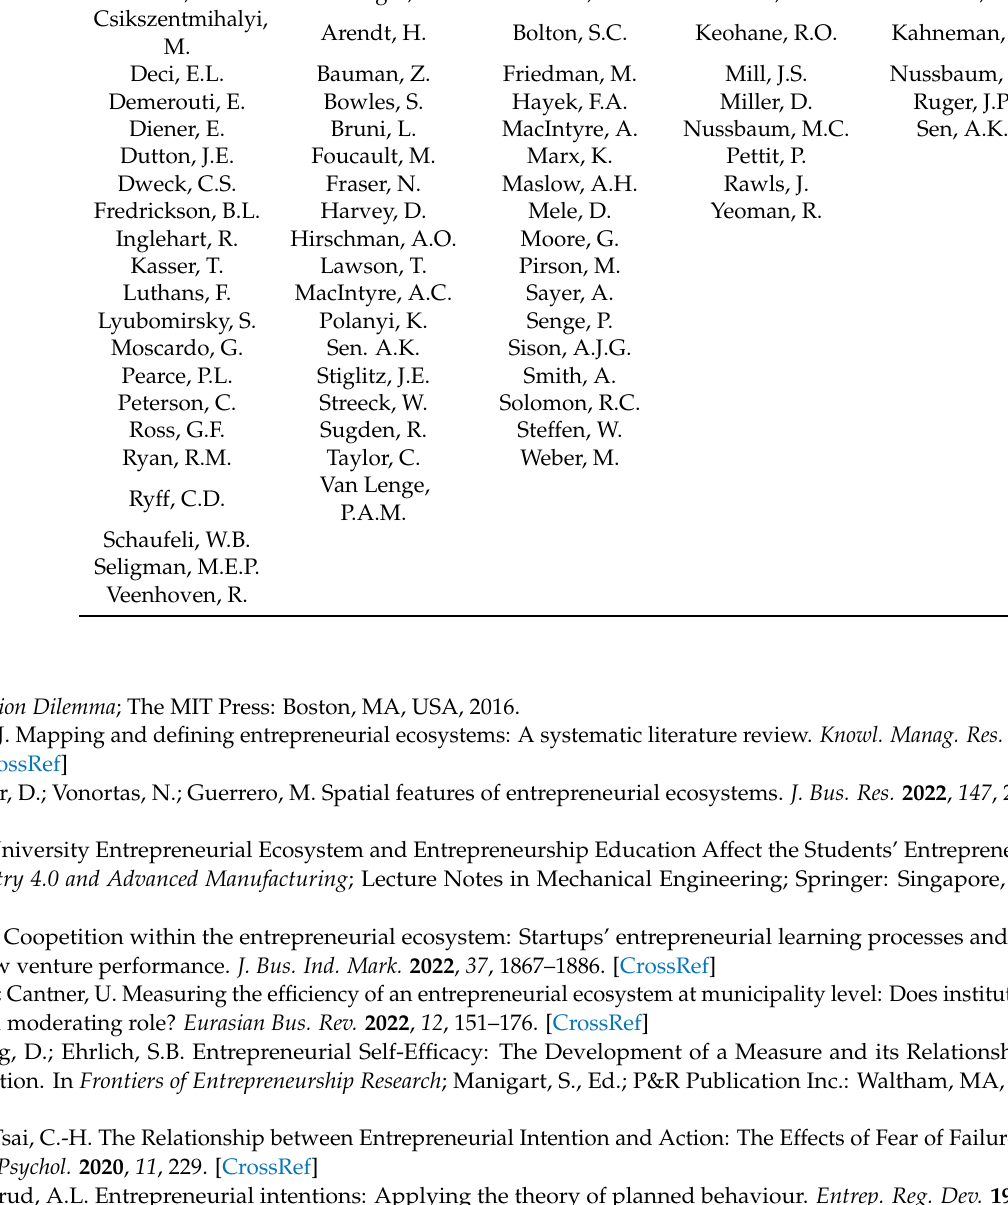
Table A2. Authors—Clusters related to HF as a keyword (SCOPUS database). Cluster 1 Cluster 2 Cluster 3 Cluster 4 Cluster 5 Bakker, A.B. Acemoglu, D. Beadle,